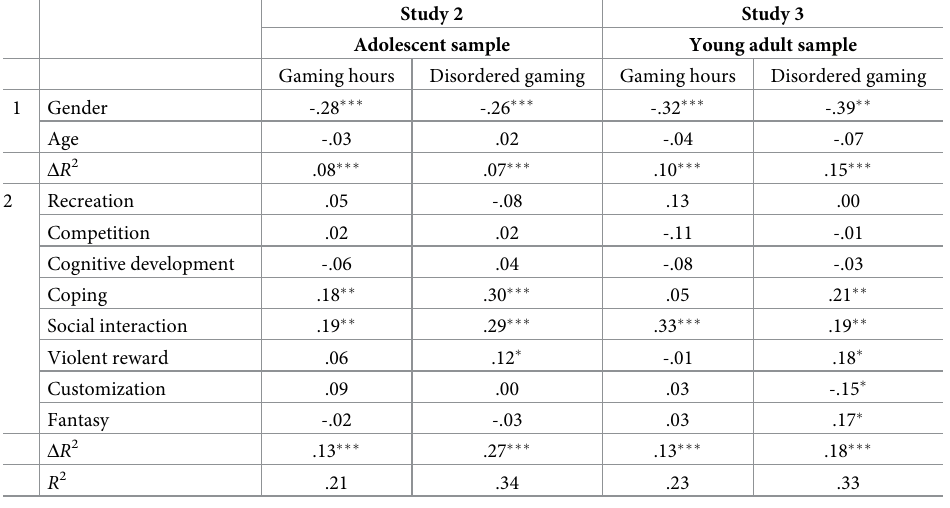
Table 4. Multiple linear regressions of hours spent gaming and disordered gaming for Studies 2 and